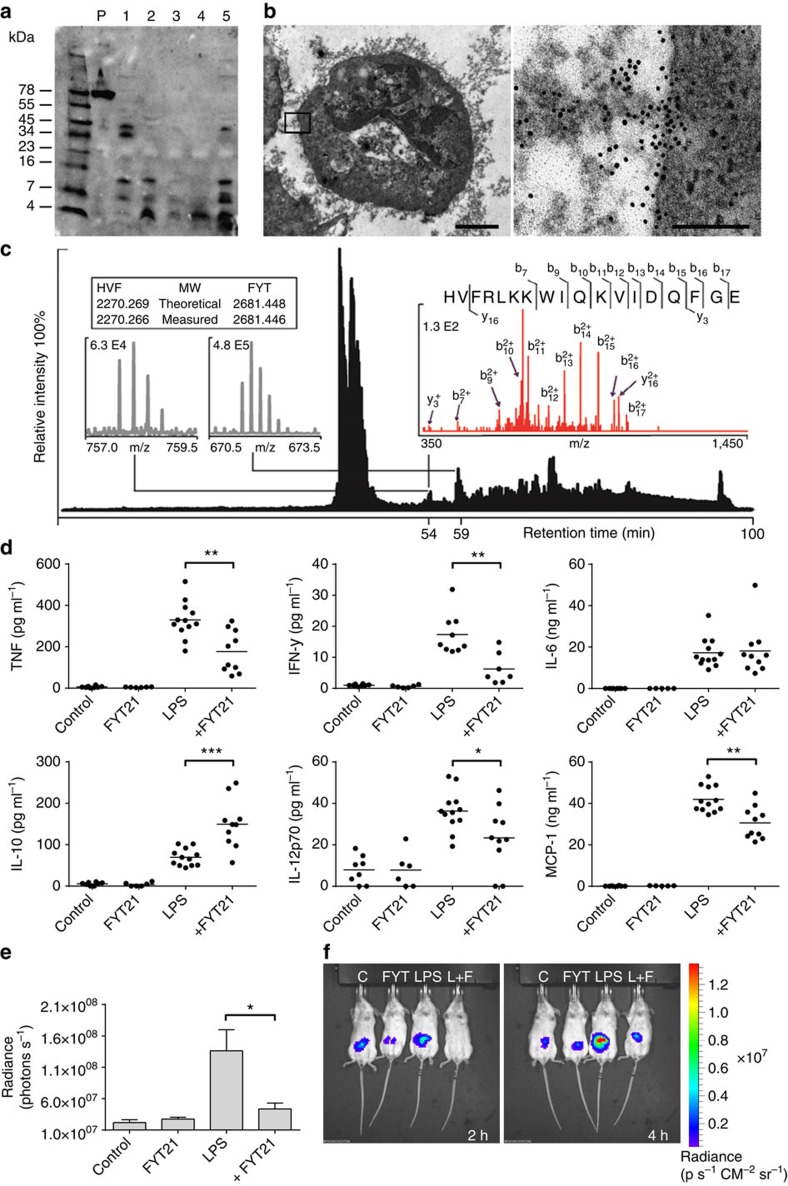
In vivo relevance of FYT21.(a) Wound fluids from non-healing leg ulcers (numbers 1–5) were analysed by western blotting using an antibody recognizing the C-terminal part of thrombin; plasma (p) is shown in lane 2. (b) An EM picture of a leukocyte, located in fibrin slough from an infected chronic wound, containing C-terminal epitopes of thrombin (black dots). The scale bars indicate 2 μm (left) and 100 nm (right). (c) Representative LC–MS/MS chromatogram of affinity purified wound dressing extract depicted in black; HVF18 eluted at 54 min and FYT21 at 59 min. The Orbitrap mass spectra of the triple-charged HVF18 peptide (m/z 757.7625) and the quadruple-charged FYT21 peptide (m/z 671.3670) enabled mass determination of both peptides (isotopic distribution depicted in grey). The assigned fragmentation pattern of HVF18 is given in red. (d) Cytokine analysis of blood collected from Balb/c mice (female 10–12 weeks), 4 h after i.p. injection with 1 mg kg−1 of LPS or PBS, which was followed after 30 min with injection of FYT21 (500 μg) or 10 mM Tris, pH 7.4. Control mice were injected twice with buffer. Results are means±s.e.m. of three independent experiments with 3–6 mice per group. (e) In vivo image of mice injected s.c. with the reactive oxygen species reporter probe L-012, 4 h after i.p. injection with 5 mg kg−1 of LPS and 500 μg FYT21 as described in d. Results are means±s.e.m. of three independent experiments with 3 mice per group. (f) A representative image of the four groups at 2 h and 4 h after injection: C, control; FYT, FYT21; L+F, LPS+FYT21. Values are significantly (*P<0.05, **P<0.005 and ***P<0.0005) different from the controls as analysed using a Mann–Whitney test.